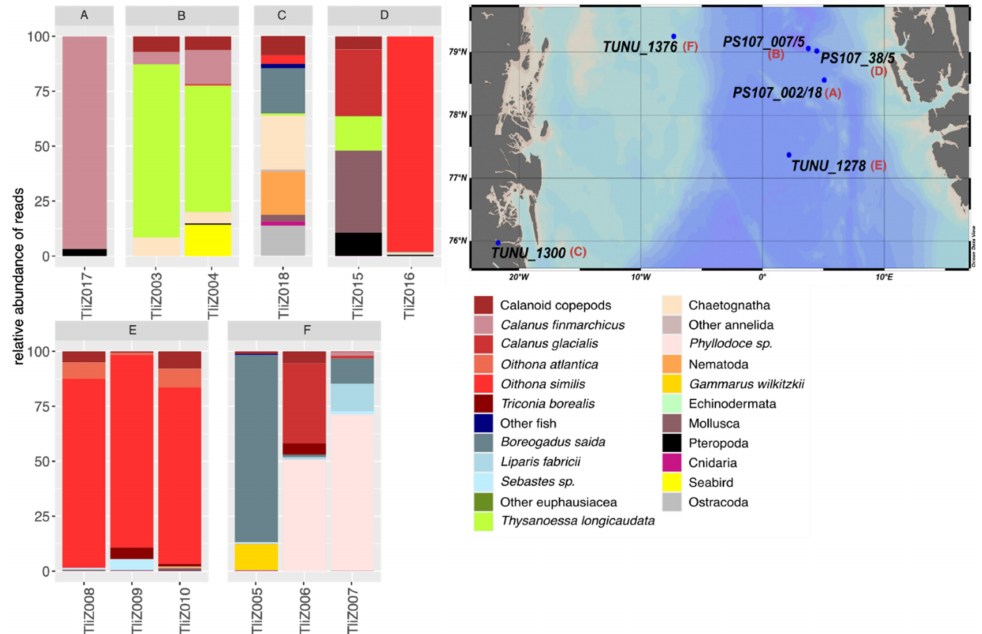
Figure 3. Prey spectrum found in the stomachs of T. libellula at different stations. Number of reads are given in relative abundances of reads per sample (RA), colors indicate different prey items, names of x-axis indicate sample IDs. Prey items contributing less than 1% to total prey reads are comprised to phylum level. Copepods are shown in red, fish in blue, and euphausiids shown in green color variants. Stations are represented by letters A–F and are shown in the